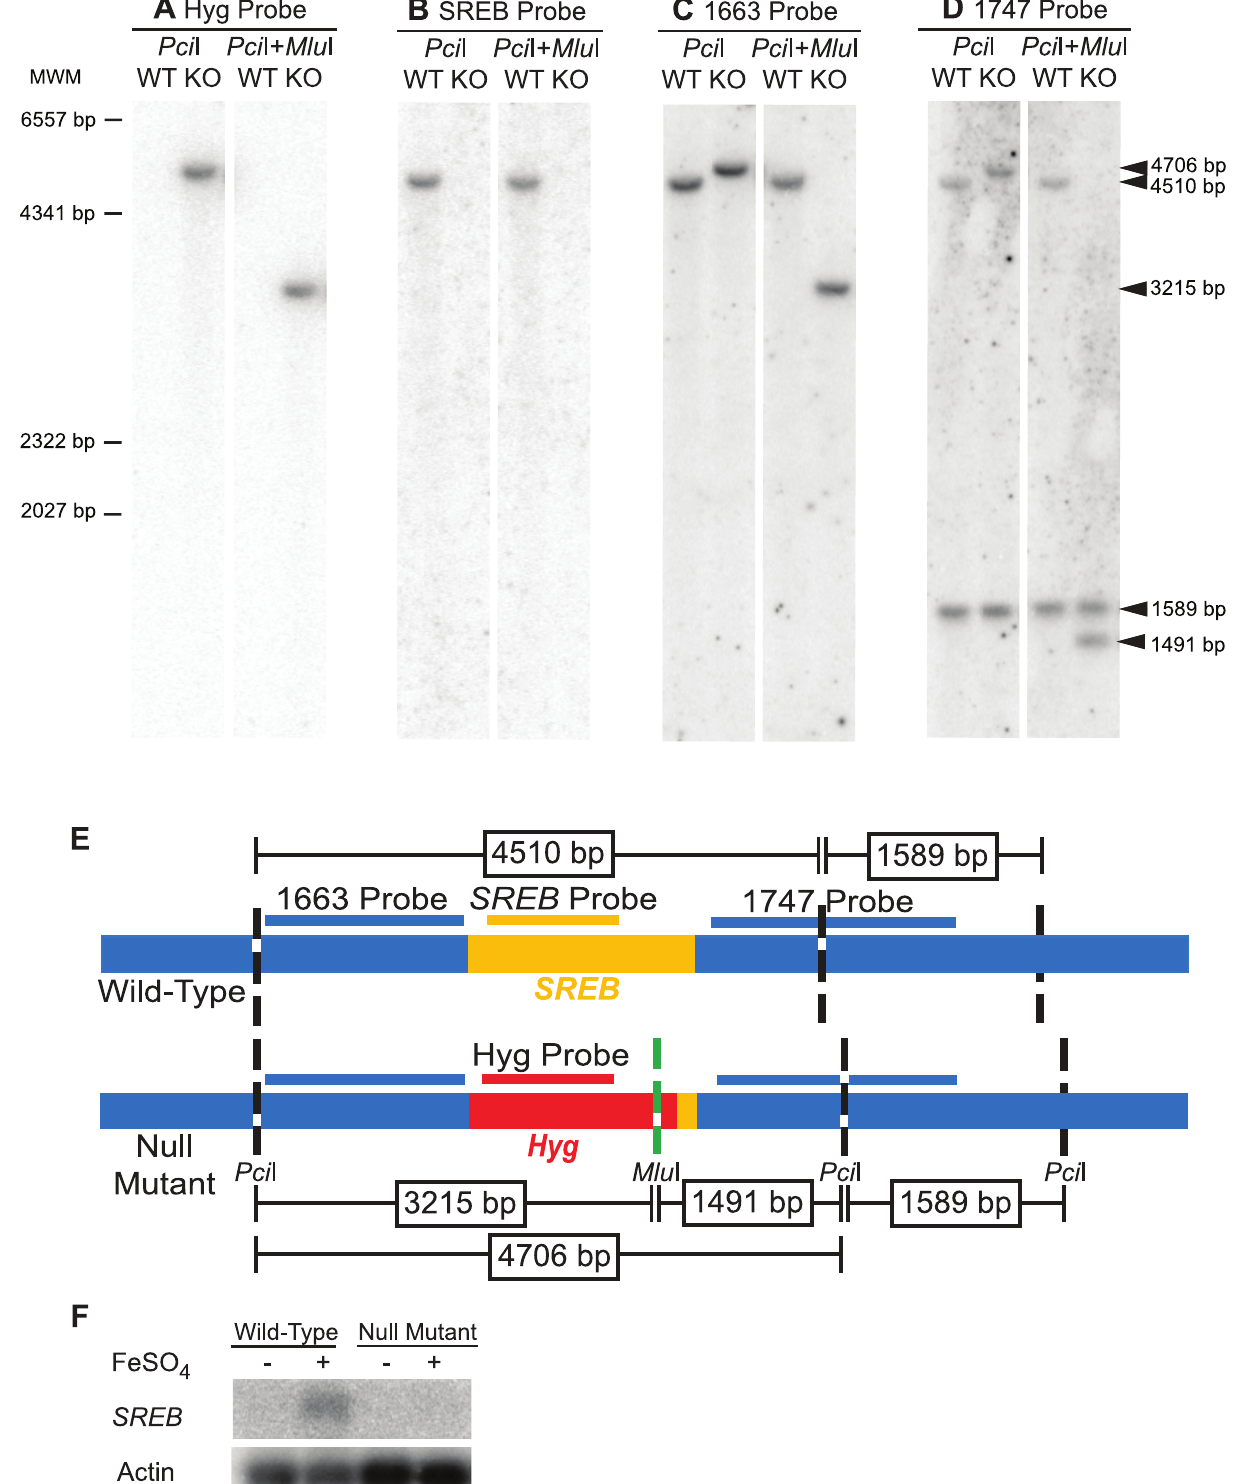
Figure 4. Southern and Northern blot analyses of the SREB null mutant. ( A-D ) Southern analysis of 26199 wild-type (WT) and null mutant SREB D (KO). Genomic DNA from WT and KO were digested with Pci I alone or in combination with Mlu I. The hygromycin resistance cassette, but not SREB , contains a Mlu I restriction site. The blots were probed against hygromycin, Hyg probe (A); SREB , SREB probe (B); the 5 9 flank, 1663 probe (C); and 3 9 flank, 1747 probe (D). Arrows indicate hybridizing fragments and dashes depict molecular weight markers (MWM). The Hyg and SREB probes failed to hybridize to digested WT or KO DNA, respectively (A, B). The 1663 and 1747 probes, which flank SREB , gave the expected size restriction fragments,